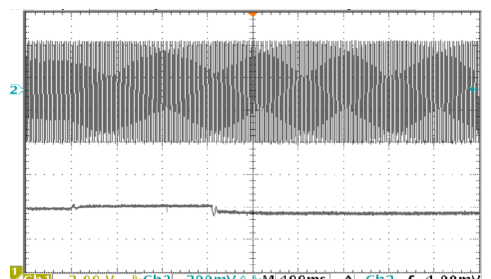
Figure 13. Battery inverter´s voltage and frequency response under step-change in the load.